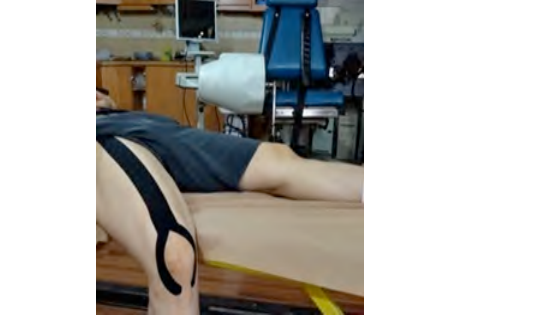
Fig 1. The model of taping in the taping group. Fig 2. Model of taping in the placebo group Table 3. The mid – term effects (24 hours) of Kinesio Tape on peak power among groups